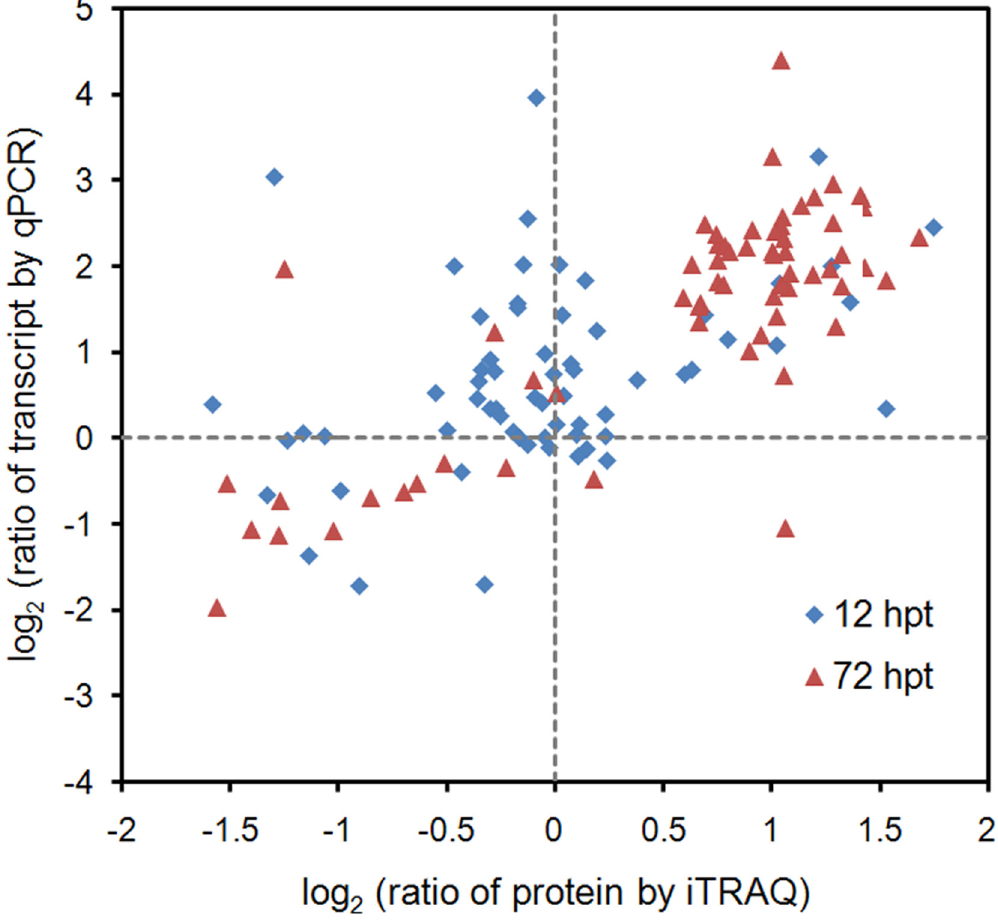
Fig 3. Comparison of the expression ratios from qRT-PCR (y-axis) and iTRAQ (x-axis) profiling. Log 2 expression ratios were calculated from SA-treated samples vs control. hpt, hours post treatment. The data represent the means of three